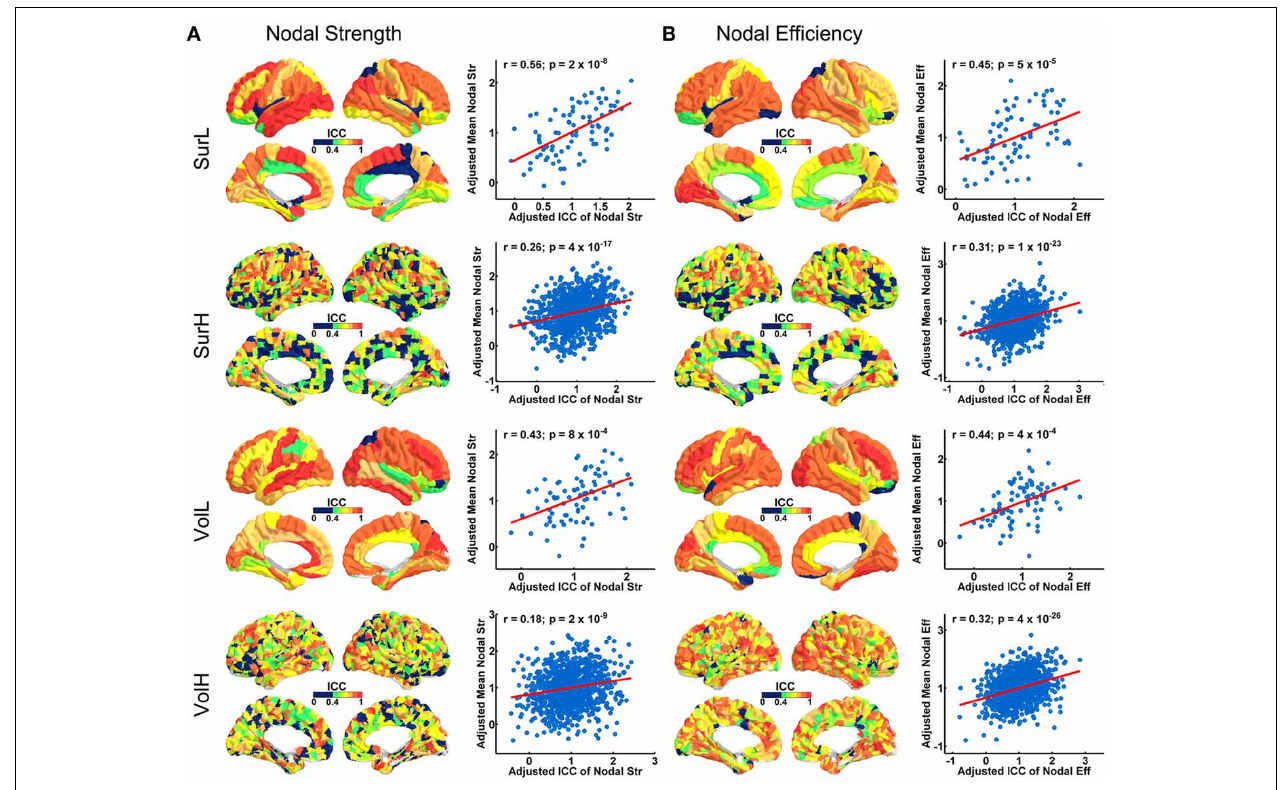
FIGURE 4 | The TRT reliability of regional network properties. (A) 3D representations of spatial distribution of ICC values of nodal strength across regions. The plots show the correlation between nodal strength and ICC values, with blue dots representing the nodes and the red line representing the linear fit. (B) 3D representations of the spatial